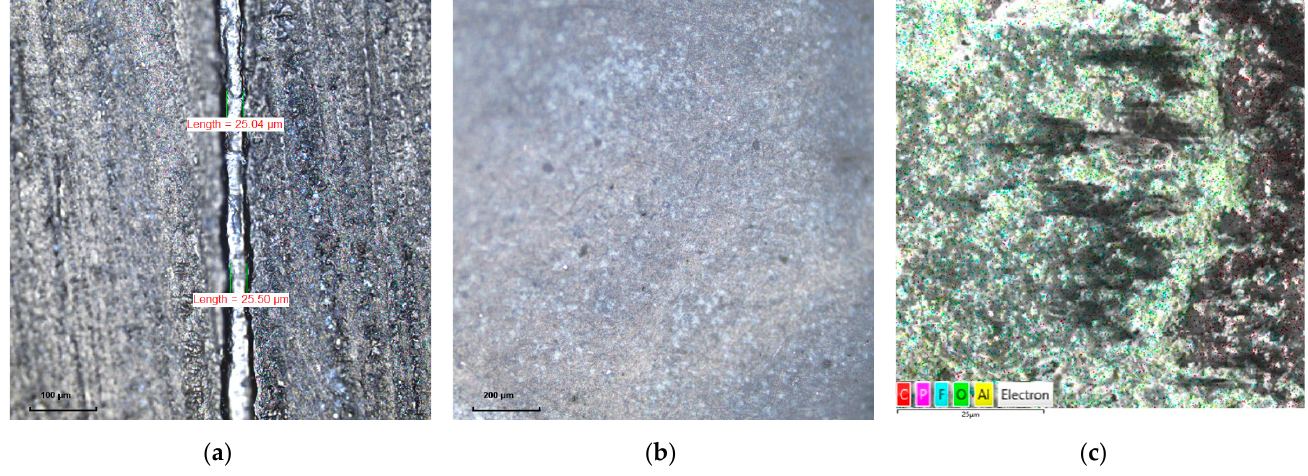
Figure 6. The separator of the battery cell: ( a ) cross ‐ section with an illustration of material layer thickness; ( b ) optical image from a confocal microscope; ( c ) EDS element map.